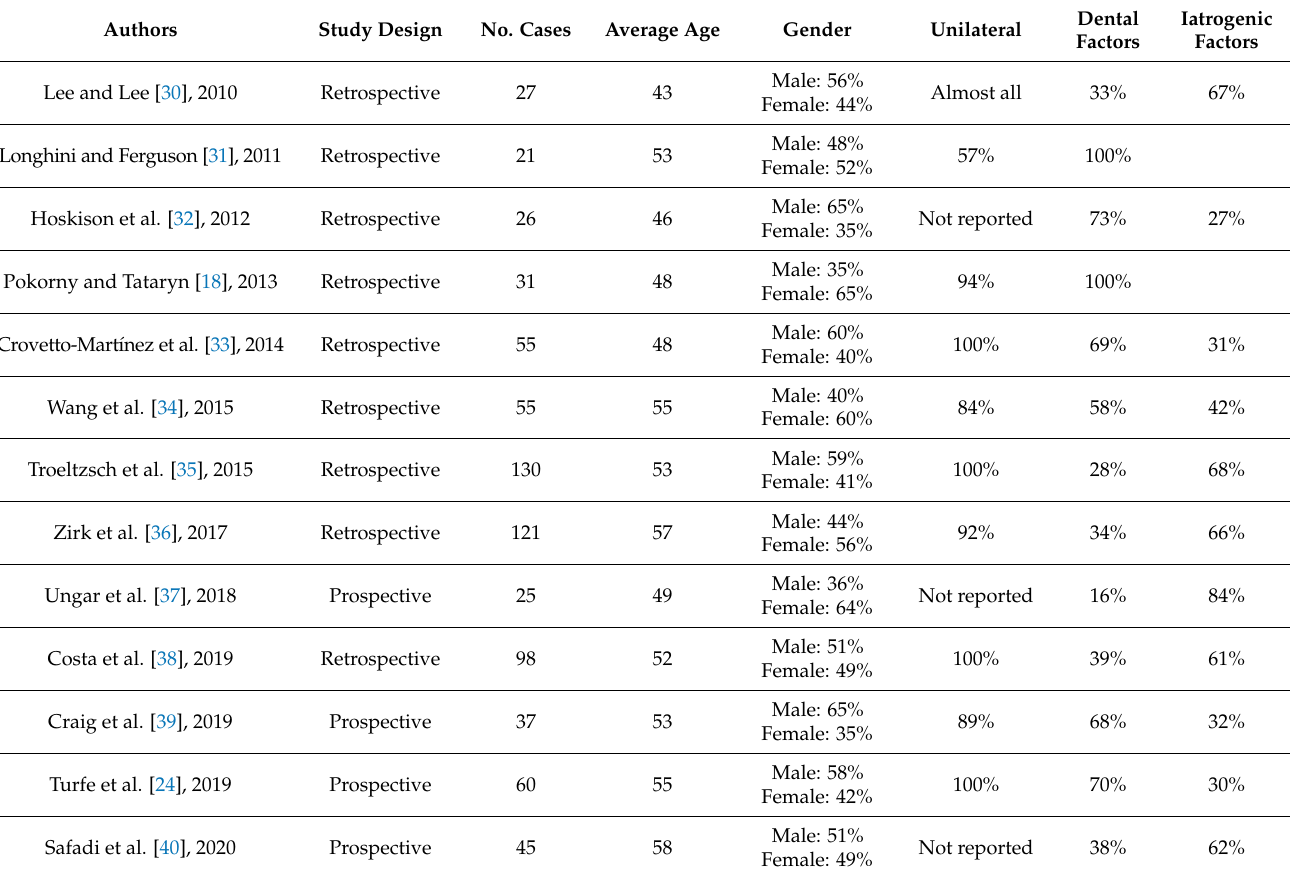
Table 8. Different studies have shown the mean age, gender, unilaterality and triggering factors of odontogenic